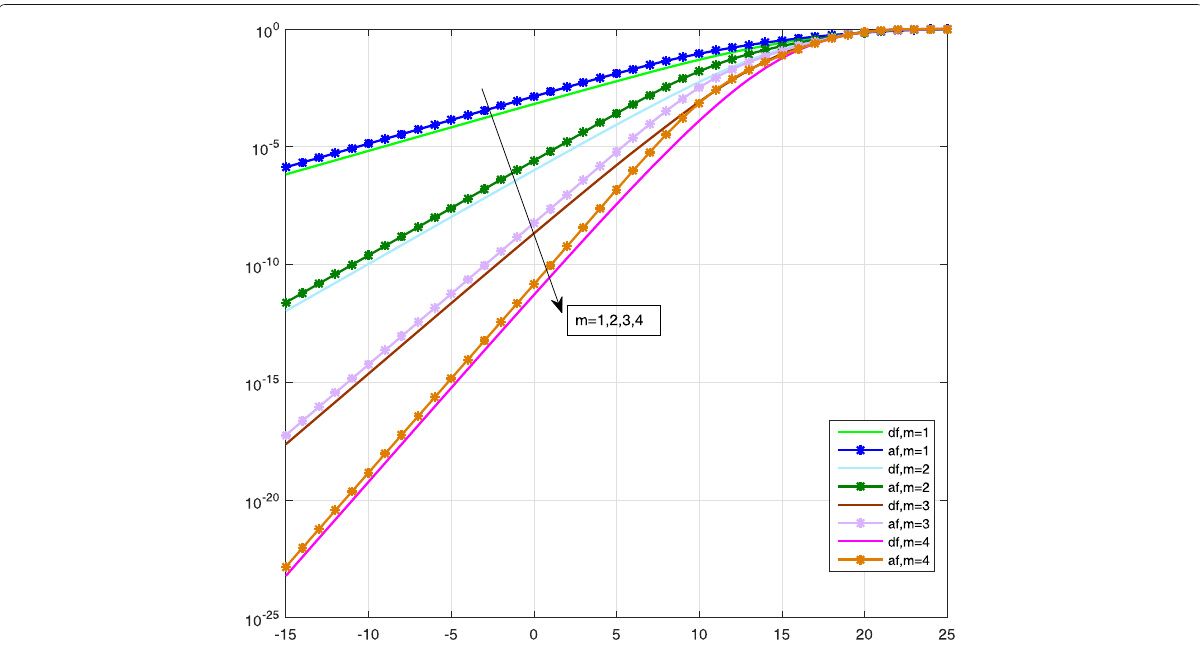
Fig. 10 Outage probability versus m = m sr = m rd = m sd for E h 2 = E h 3 with DF and